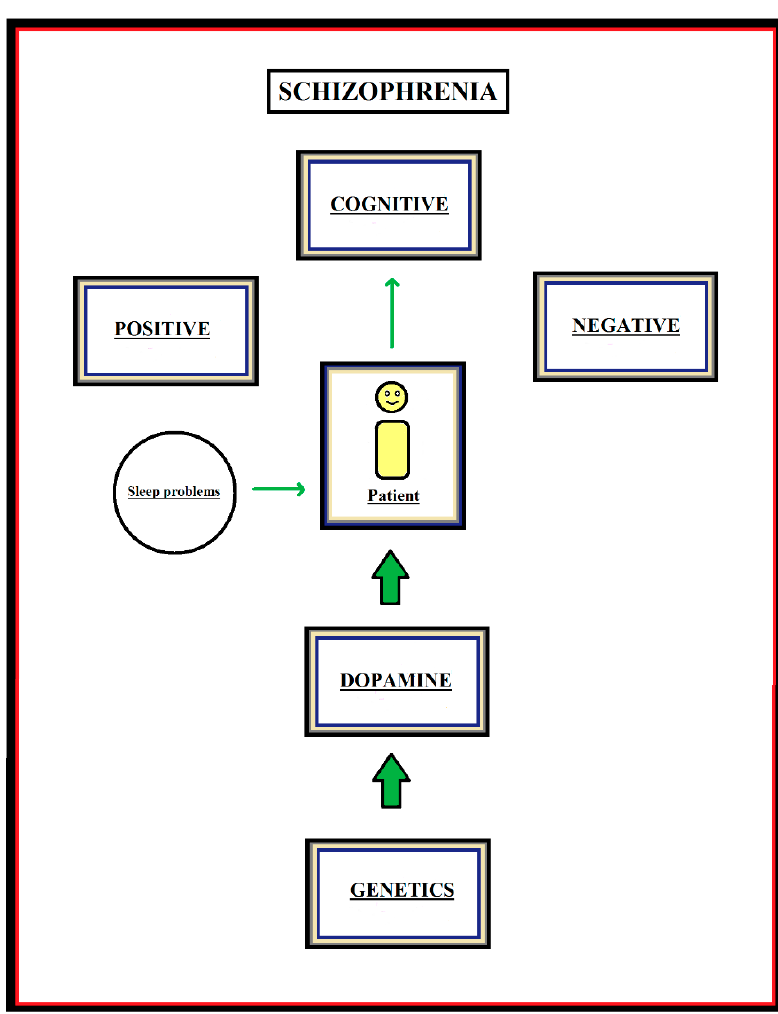
Figure 1. Overview of the clinical symptoms of patients with schizophrenia and the key factors that are the focus of the present special issue and are suggested to influence those symptoms.